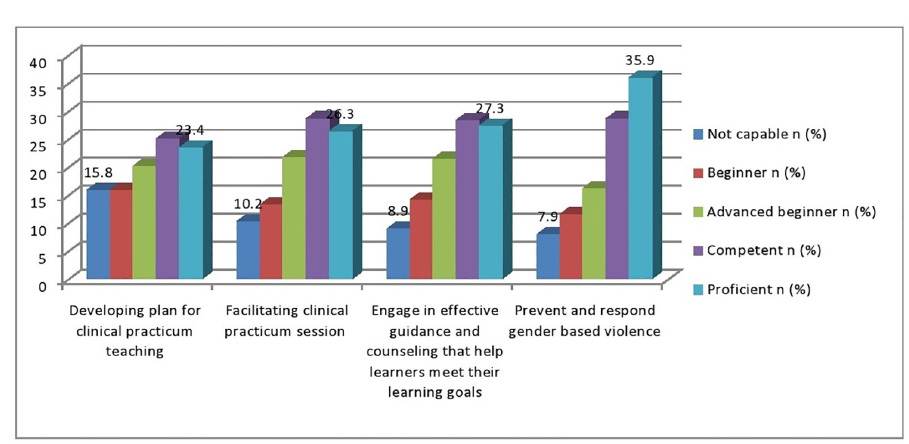
Fig 2. Apply principles of gender responsive pedagogy of preceptors for Medical Laboratory Science clinical practicum education programs in Ethiopia, 2021(N = 304).